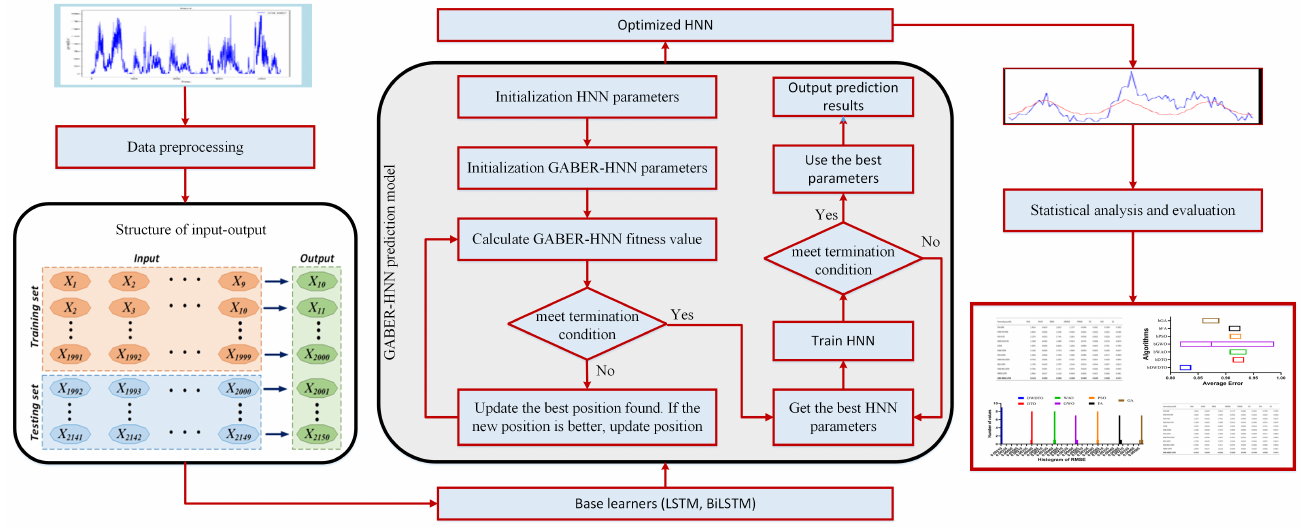
Figure 6. Flowchart of the steps included in the proposed renewable energy forecasting